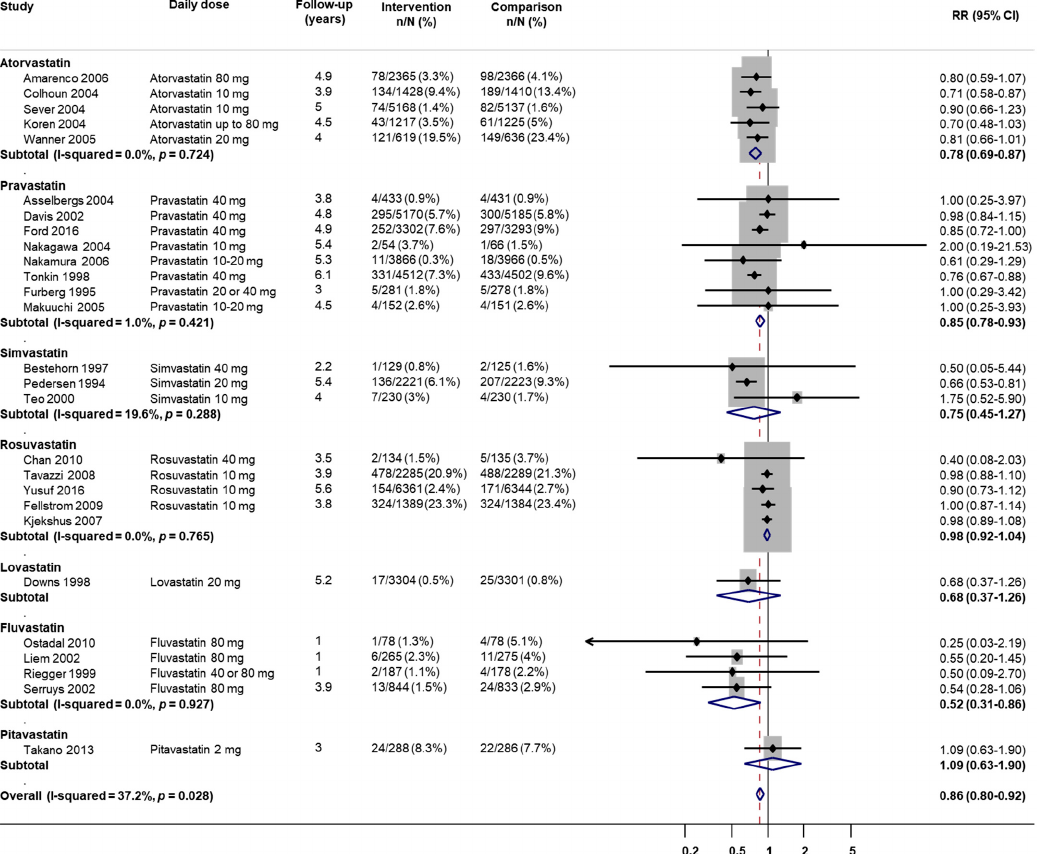
Figure A4. Subgroup meta-analysis for the effect of different statins on cardiovascular disease death. Full black quadrilateral represents the point estimate of individual studies and blank with quadrilateral represents pooled estimates. RR, relative risk; CI, confidence interval. Bold font indicates statistical significance. Pooled estimates for the overall study population and subgroups are highlighted with bold